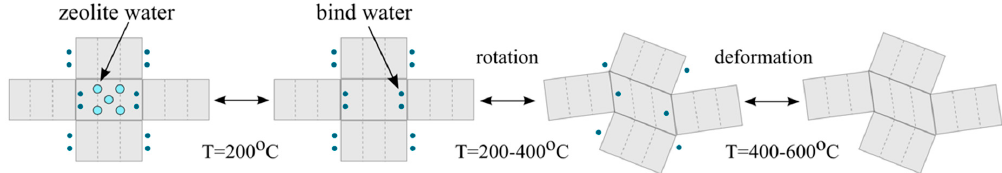
Figure 4. Changes in the structure of the sepiolite under the influence of temperature [16].